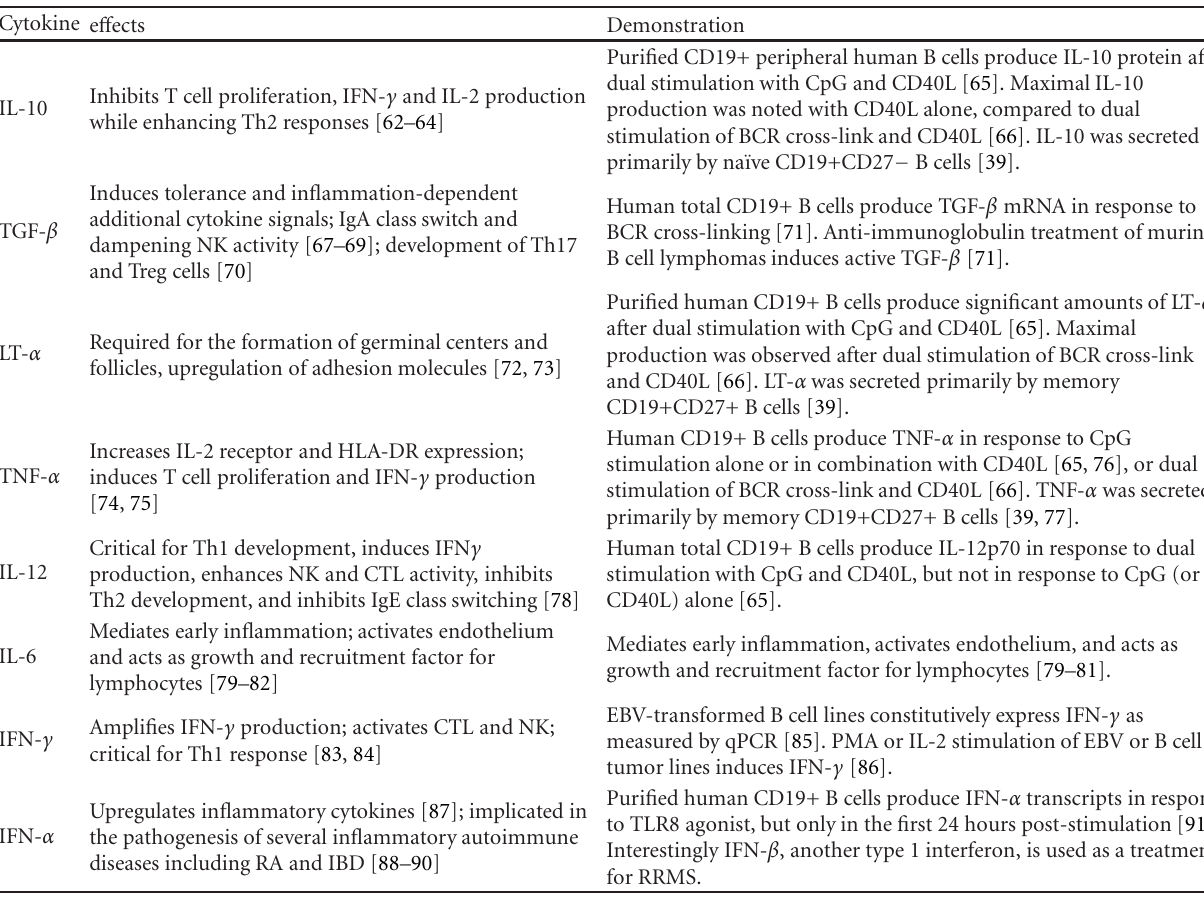
Table 1: Cytokines produced by B